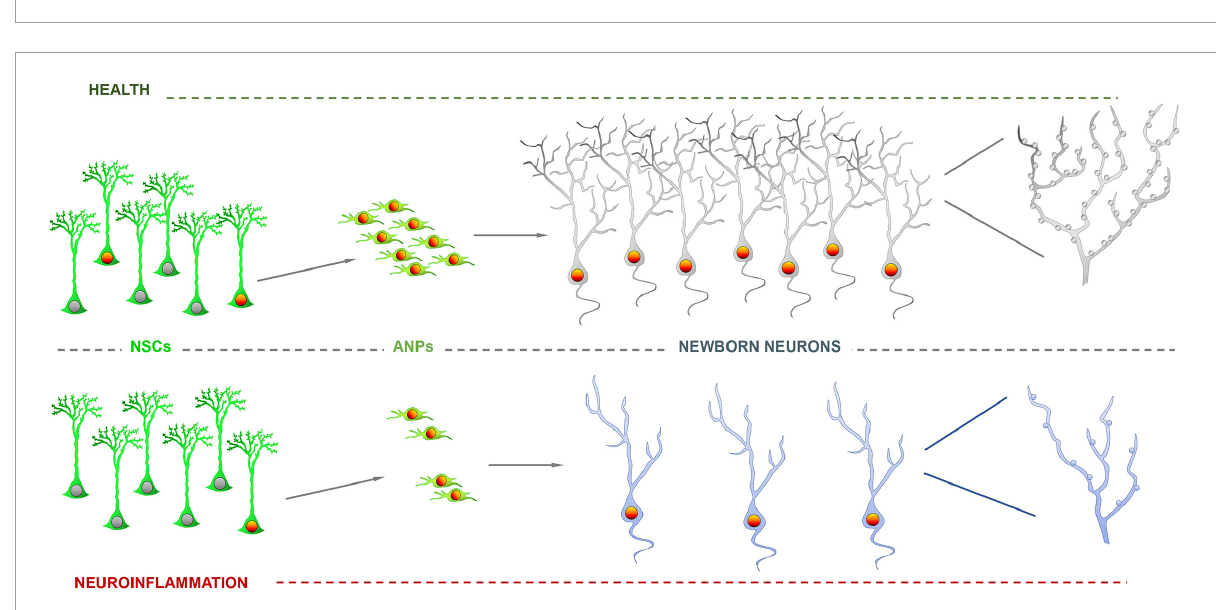
FIGURE3 Impairment of neurogenesis due to neuroinflammation. Neural stem cell (NSCs) activation and precursor proliferation are reduced by inflammatory agents such as interleukins, which translates in a lower number of newborn neurons. Further, neurons born or differentiated under neuroinflammation exhibit a dystrophic phenotype with less developed dendritic arborization and fewer dendritic spines.